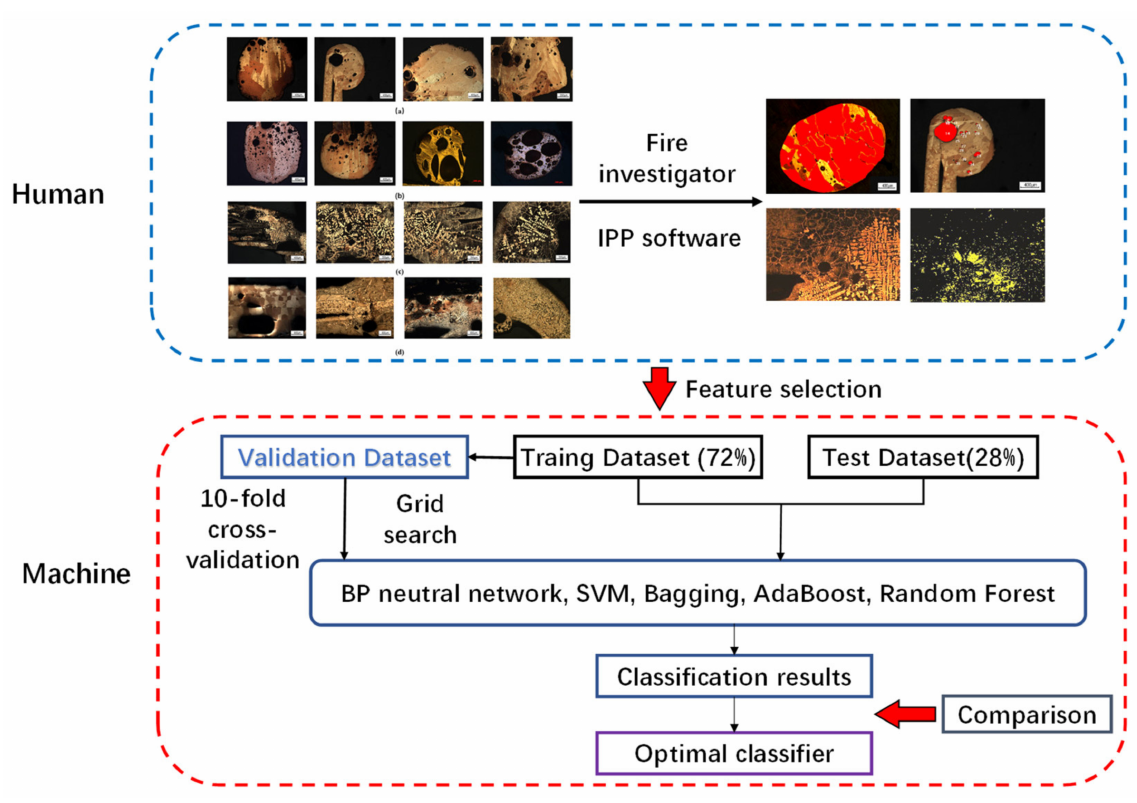
Figure 4. Flowchart of the bead classification